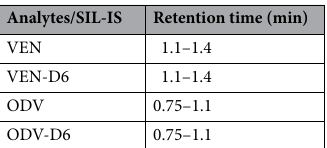
Table 2. Retention time for the analytes and their SIL-IS.